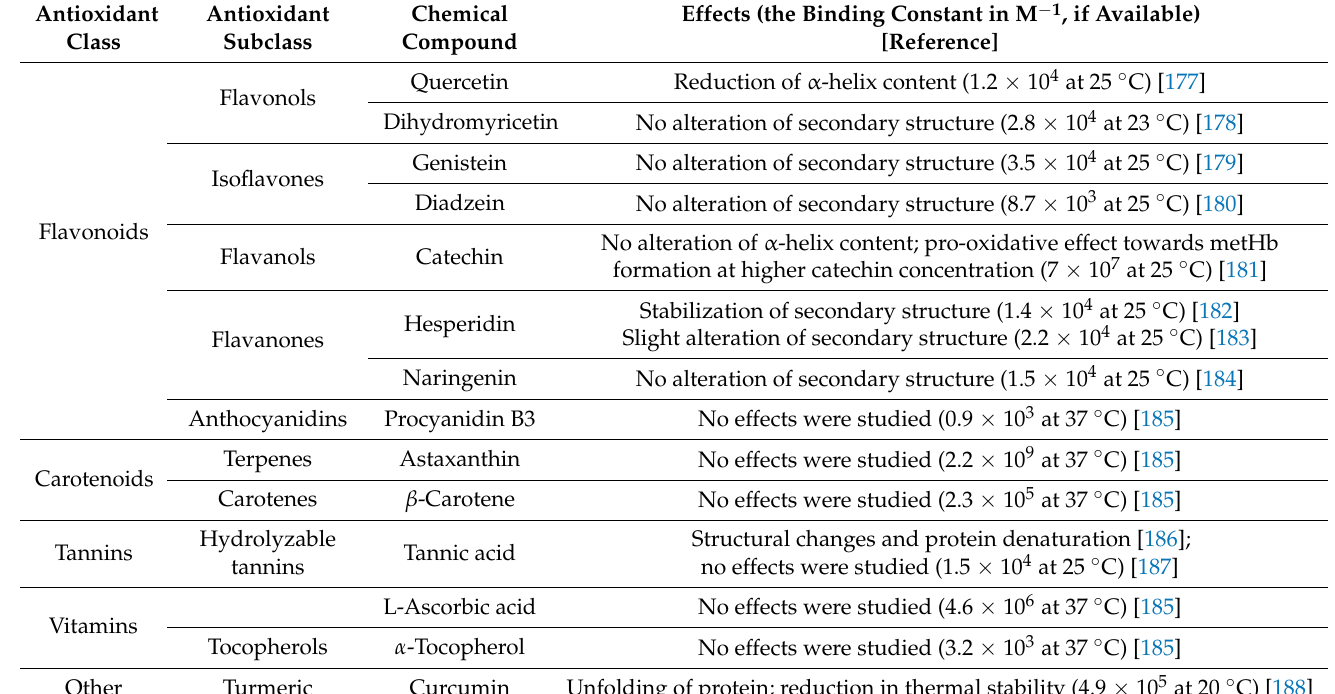
Table 5. Known interactions between food antioxidants and human hemoglobin